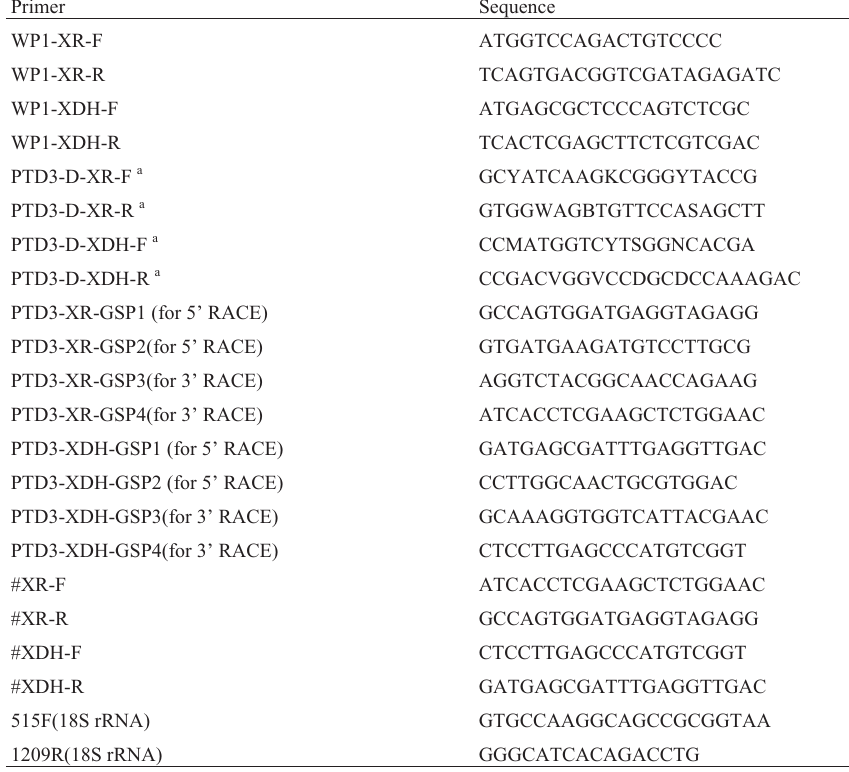
Table 1 - Primers used in the